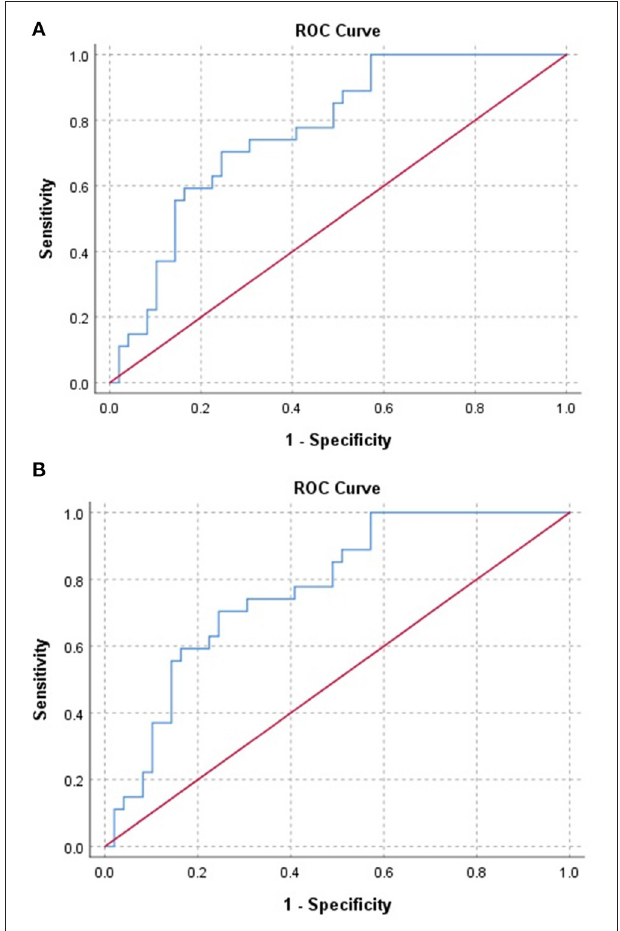
FIGURE 2 | (A) Receiver Operator Curve (ROC) of red blood cell distribution width (RDW) values in coronavirus disease 2019 (COVID-19) patients for predicting mortality. (B) Receiver Operator Curve (ROC) of red blood cell distribution width (RDW) values in coronavirus disease 2019 (COVID-19) patients for predicting septic